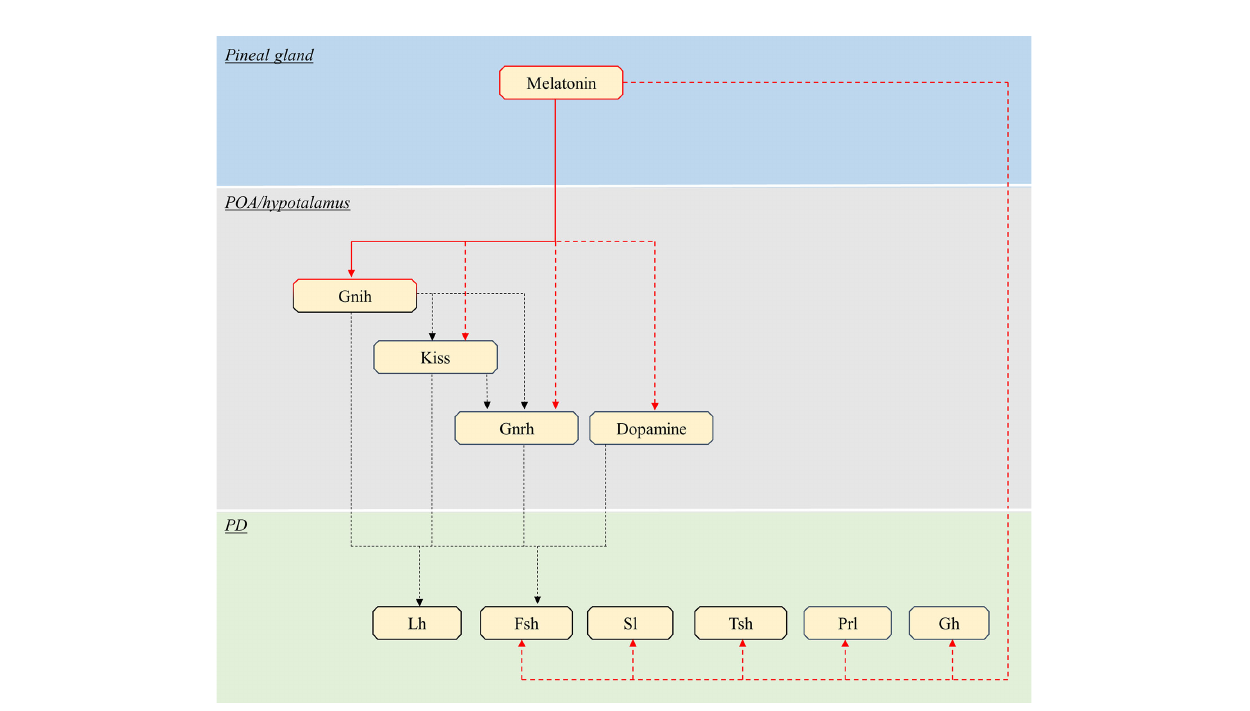
FIGURE 4 | Schematic view of the putative pathways through which melatonin in fl uence pituitary endocrine activity in teleosts. Red continuous lines indicate cell types directly targeted from melatonin. Dashed red lines indicate cells in fl uenced by melatonin via yet unidenti fi ed interneurons, paracrine signals or Mtnr Note that melatonin might act only on a few of the illustrated pathway, in different species (see text). Black dashed lines indicate all other interactions between brain and pituitary. POA, preoptic area ; PD, pars distalis ; Kiss, kisspeptin; Gnrh, gonadotropin-releasing hormone; Lh, luteinising hormone; Fsh, follicle-stimulating hormone; Sl, somatolactin; Tsh, thyroid-stimulating hormone; PRL, prolactin; GH, growth